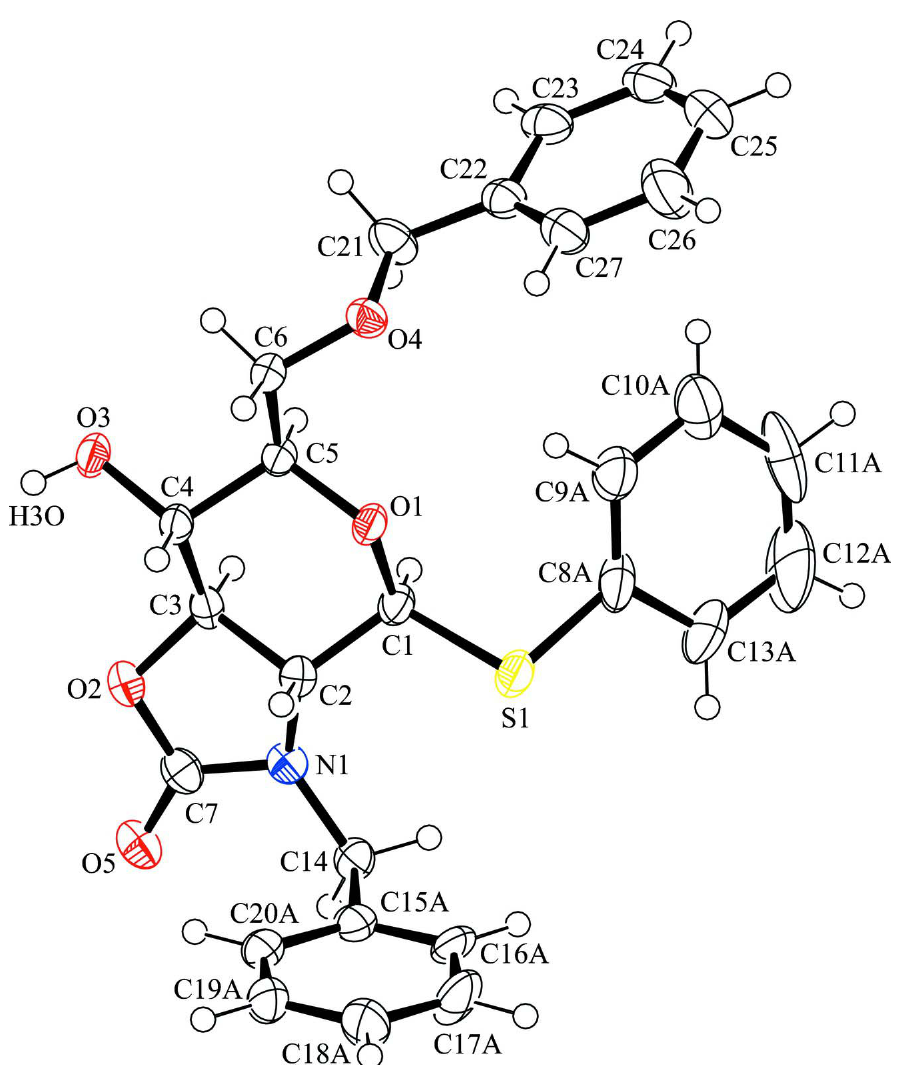
A view of the molecular structure of (I), showing the atom labeling scheme. Displacement ellipsoids are drawn at the 50% probability level. The minor parts of the disordered phenyl moieties are omitted for